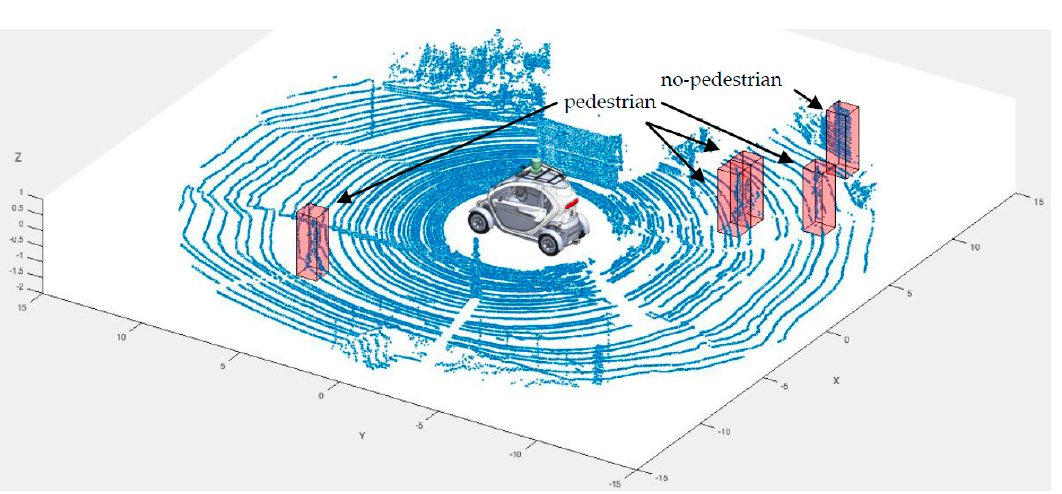
Figure 11. Pedestrian detection algorithm on real traffic area.